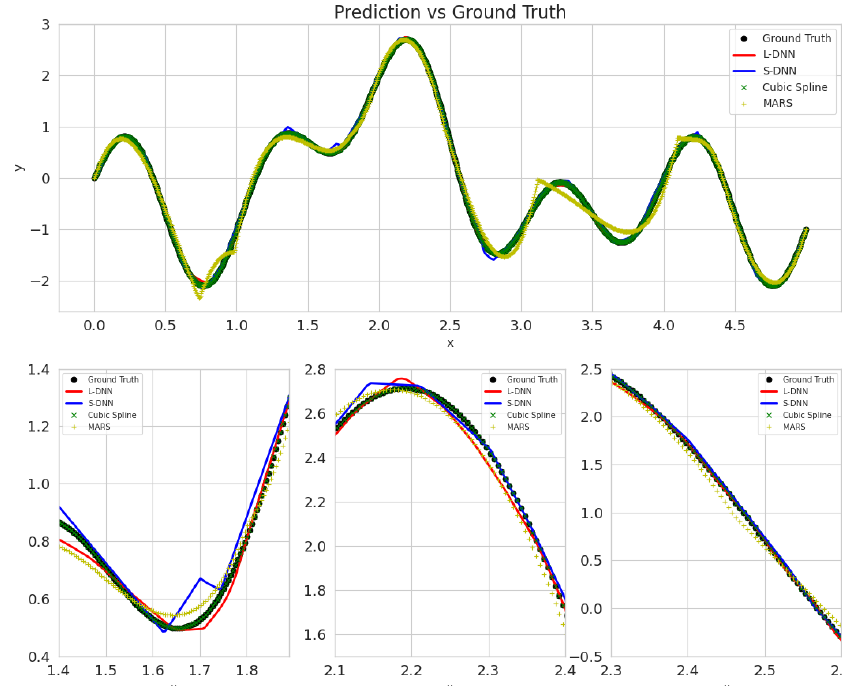
Figure A1. Predictions’ of all tested methods on the test set for noise = 0%, trained on 50 samples. Blue represents SDNN, red LDNN, green cubic splines, and yellow MARS.